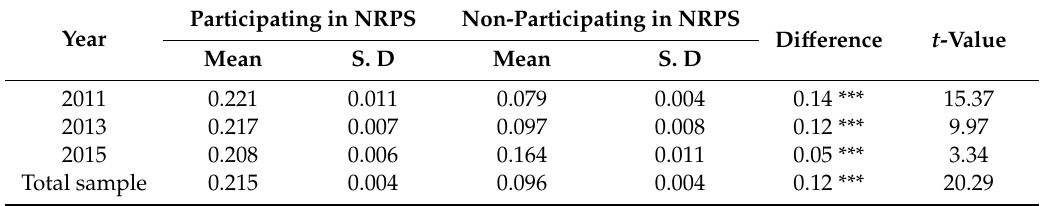
Table 1. Ratio of farmers who transferred land by participating and non-participating in NRPS. Participating in NRPS Non-Participating in NRPS Year Di ff erence Mean